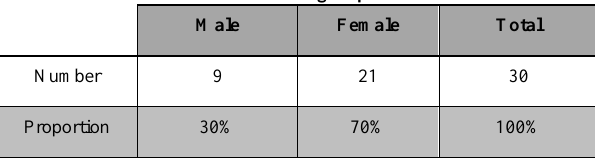
Table 1. Distribution of male and female subjects among both study and control